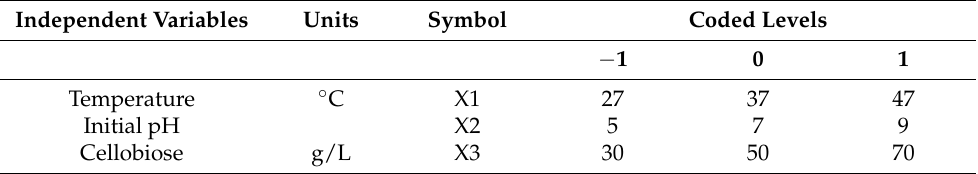
Table 1. Factors, codes and actual levels for design of the present research